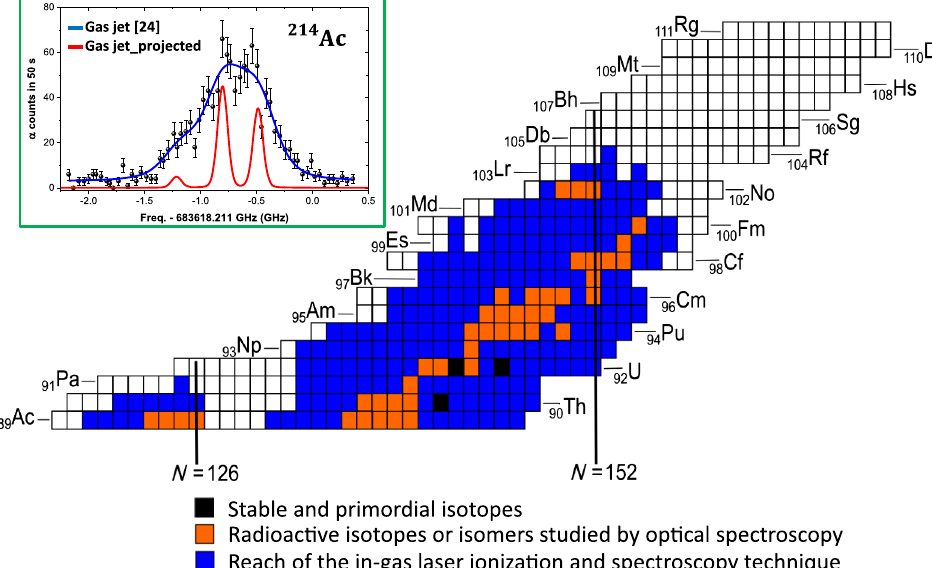
FIG. 1. Enlargement of the chart of nuclides in the actinides region: stable and primordial isotopes are shown by black squares, radioactive isotopes already studied with laser spectroscopy are shown in brown [1]. The elements which can be produced in sufficient amounts for the IGLIS technique are highlighted in blue with the prediction based on experimental and calculated cross sections and assumptions of a primary beam intensity of 10 p μ A, an efficiency of the method of 10% and yields of 0.1 p.p.s. extracted from the gas cell. This corresponds to a lower limit in production cross section of 50 nb. In the inset, the hyperfine structure of the 6 d 7 s 2 2 D 3 = 2 → 214 Ac as measured using the in-gas-jet method is shown (black dots) with the blue curve representing 6 d 7 s 7 p 4 P 0 5 = 2 transition in atomic the best fit using a Voigt line profile. The frequency detuning is shown with respect to the center of gravity of the 227 Ac isotope. The expected performance of the in-gas-jet method at Mach number M ¼ 10 is shown with the red